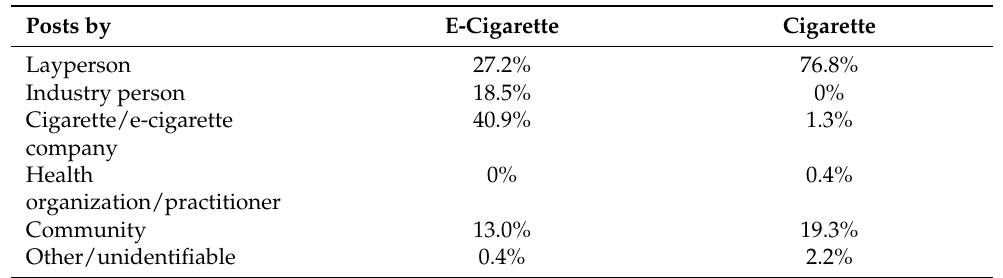
Table 1. Ratio of posts by source